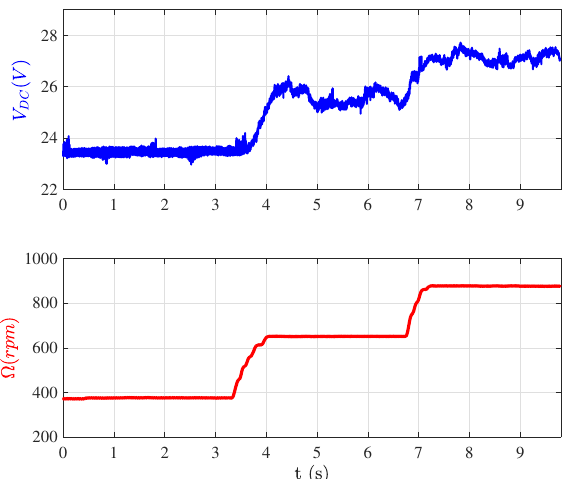
Figure 8. Influence of the velocity on the DC bus voltage. The other parameters are set to: I ref = 16 A, ψ = 180 ◦ , θ p = 150 ◦ , and R L = 15 Ω .